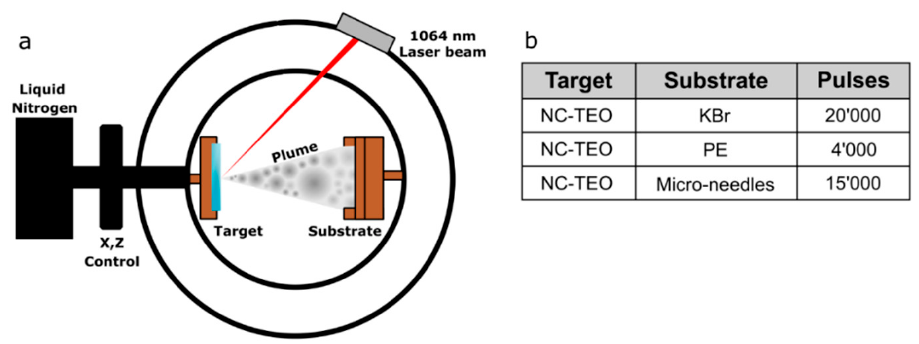
Figure 6. Schematic of MAPLE equipment ( a ) and deposition parameters for the three selected substrates ( b ).